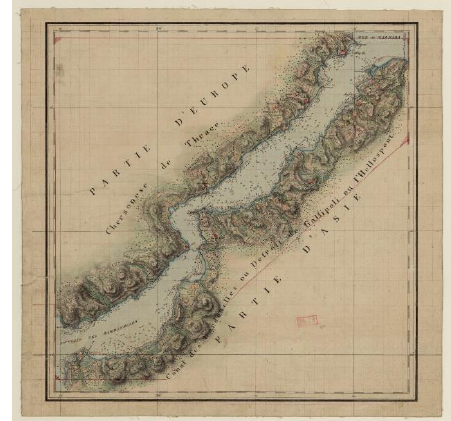
Figure 02 : Gravure 01. Sr Berquin's Kilitbahir Castle Plan; National Library of France, Map and Planning